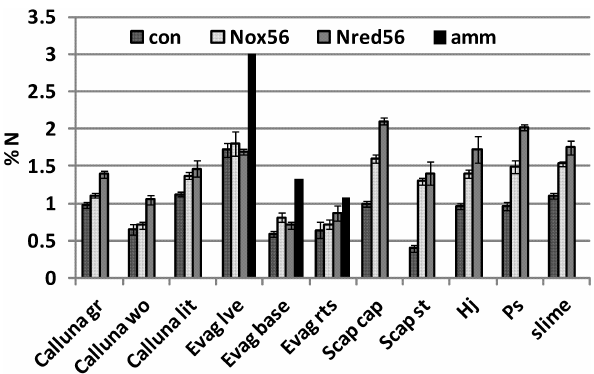
Fig. 2. Percentage of N (drywt) ( + / − sterr) in the main above- ground vegetation on the control (no added N) and N treated (oxidised (Nox), reduced (Nred) and ammonia (amm)) plots ( ∼ 56kgNha − 1 yr − 1 ) at Whim bog in 2009: green Calluna shoots ( Calluna gr), Calluna woody stems ( Calluna wo), Calluna lit- ter ( Calluna lit), Eriophorum vaginatum green leaves (Evag lve), E. vaginatum leaf sheaths (Evag base), E. vaginatum surface roots (Evag rts), Sphagnum capillifolium capitula (Scap cap), S. capilli- folium brown stem (Scap st), Hypnum jutlandicum (Hj), Pleurozium schreberi (Ps) and slime (necrotic senescing hypnaceous moss and fine roots). Values for all but Evag are missing for the amm treat- ment as there was no material to